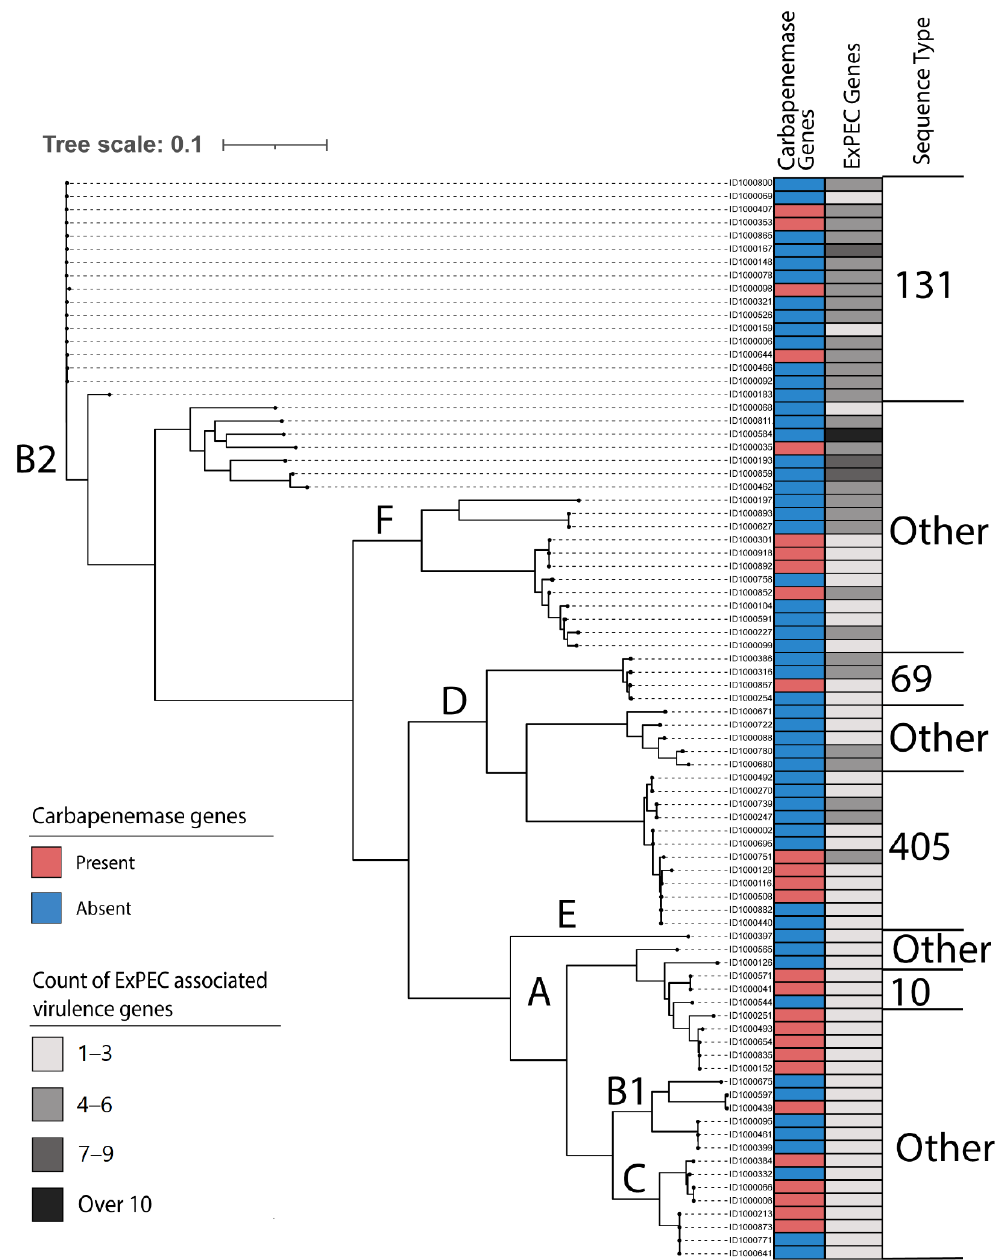
Figure 1. Maximum likelihood phylogenetic tree of 82 carbapenem resistant E. coli isolates from Alameda County Health systems 2017 –2019, derived from a core alignment of 18,587 core SNP’s. The tree was generated using the general time reversible model with FigTree. A, B1, B2, C, D, E, and F are insilico ClermonTyper phylogenetic groups. The presence of any carbapenemase genes and the count of ExPEC virulence genes per isolate are indicated. The pandemic sequence types are annotated. “Other” sequence types include all sequence types other than ST131, ST69, ST405, and ST10 detected in the sample group.